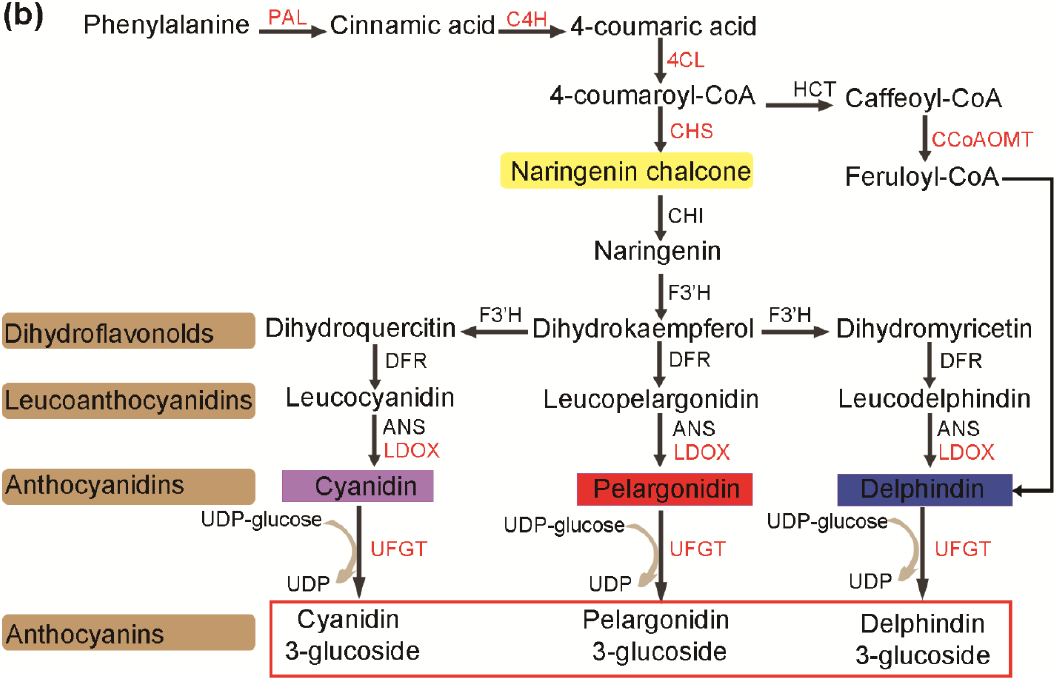
Figure 5. Combined analyses of anthocyanin-related genes and metabolites. ( a ) Nine-quadrant flat. The x-axis represents the log2 ratio of genes. The y-axis represents the log2 ratio of metabolites. Black dotted lines represent different threshold and divide the flat into 1 (cid:13) – 9 (cid:13) quadrants from left to right and from top to bottom. ( b ) Diagram of genes involved in regulating anthocyanins. The red enzymes represent upregulated genes. PAL: phenylalanine ammonia lyase; 4CL: 4-coumarate CoA ligase; C4H: trans-cinnamate 4-monooxygenase; HCT: shikimate O-hydroxycinnamoyltransferase; CHS: chalcone synthase; CHI: chalcone isomerase; F3H: flavanone 3-hydroxylase; F3 (cid:48) H: flavonoid 3 (cid:48)